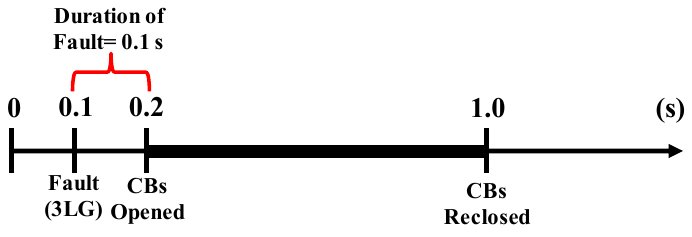
Figure 10. Triple-line-to-ground (3LG) fault conditions.